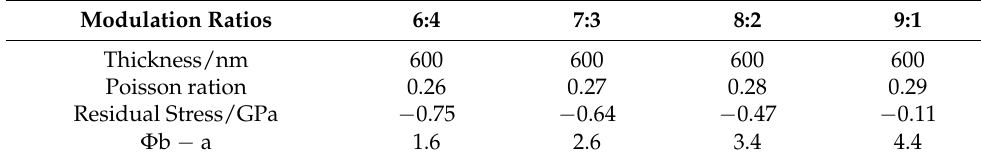
Figure 7. Image of indentation with crack pattern for Mo/VC multilayers with η Mo/VC = 8:2. Table 2. Parameters required for toughness of Mo/VC